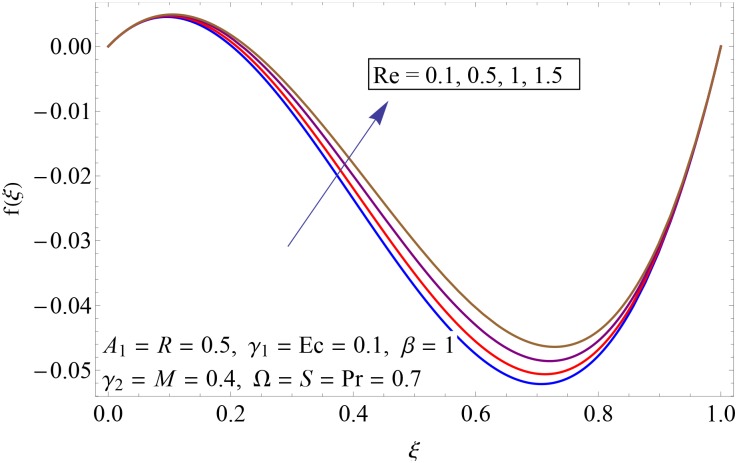
Impact of Re on f(ξ).